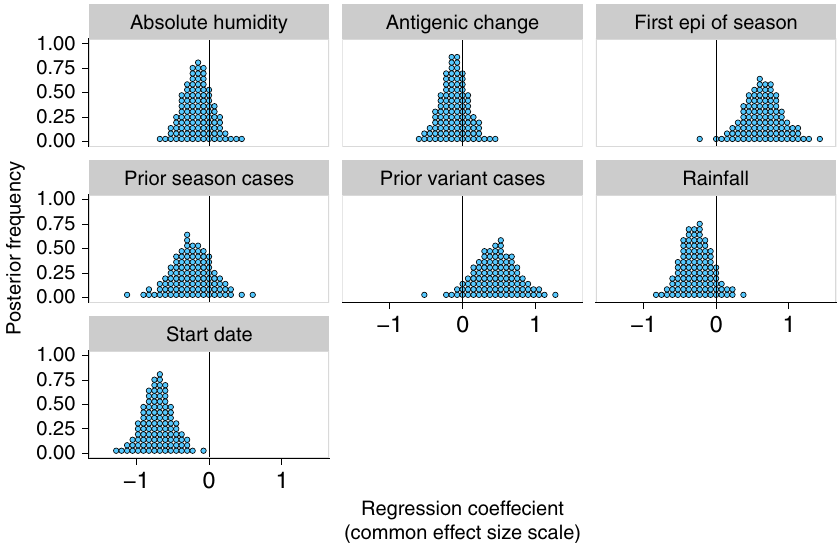
Fig. 6 Joint contributions of climatic and virological factors on epidemic incidence. The mean effects across all subtypes were estimated using the Bayesian multilevel model. Predictors were mean-centred and scaled, so effect sizes are shown on a common